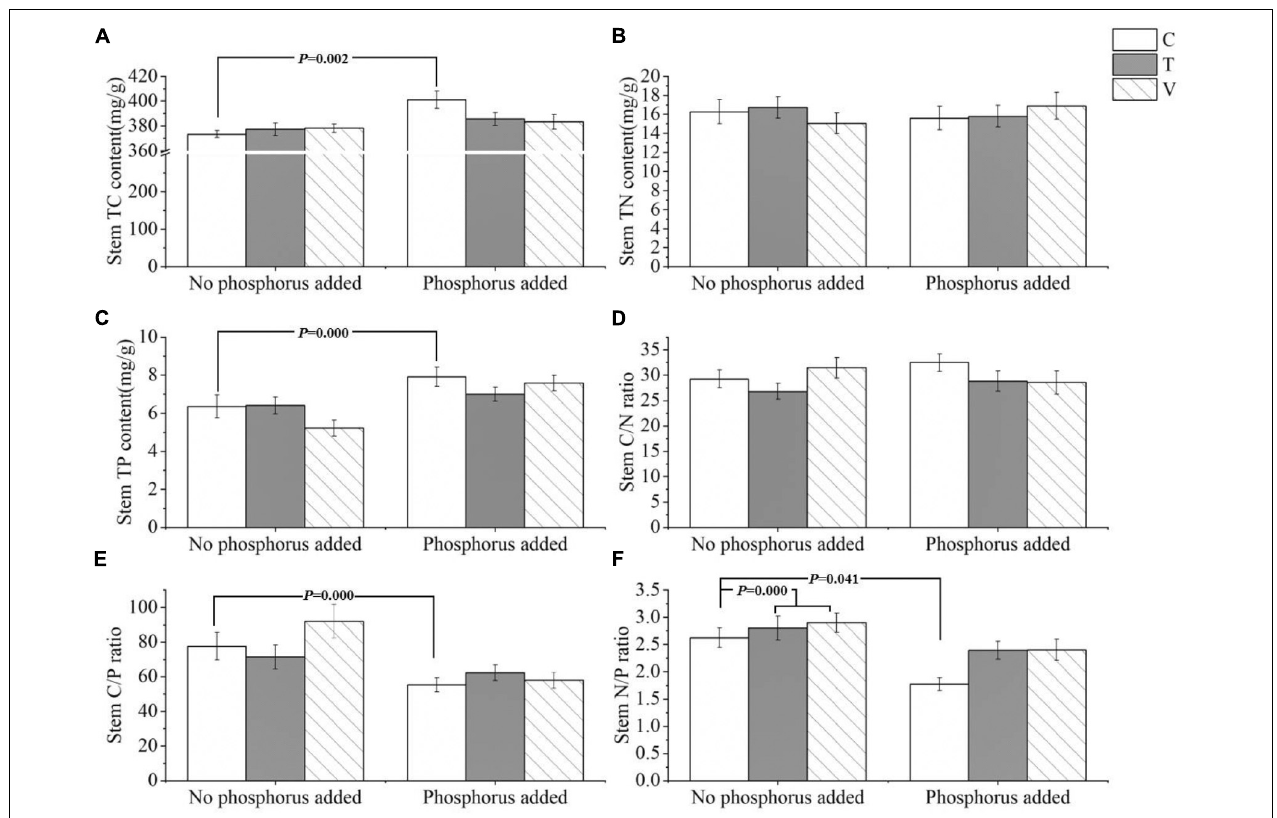
FIGURE 2 | The stoichiometric characteristics of the (A) TC, (B) TN, and (C) TP contents and the (D) C/N, (E) C/P, and (F) N/P ratios of P. crispus stems under different treatments. The C in “No phosphorus added” represent controls (C), T in “No phosphorus added” represent constant warming (T), and V in “No phosphorus added” represent variable warming (V). Meanwhile, the C in “Phosphorus Added” represent phosphorus addition (C + P), T + P in “Phosphorus Added” represent constant warming and phosphorus addition (T + P), and V + P in “Phosphorus Added” represent variable warming and phosphorus addition (V +